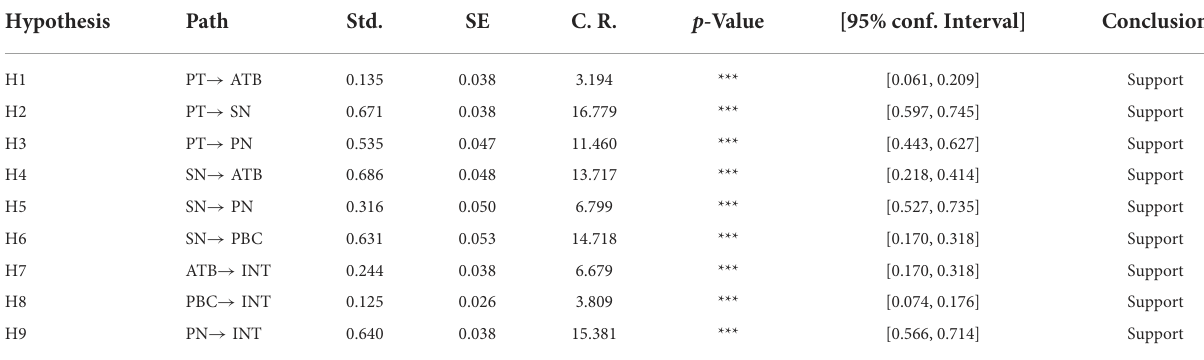
TABLE 6 Path coefficient of